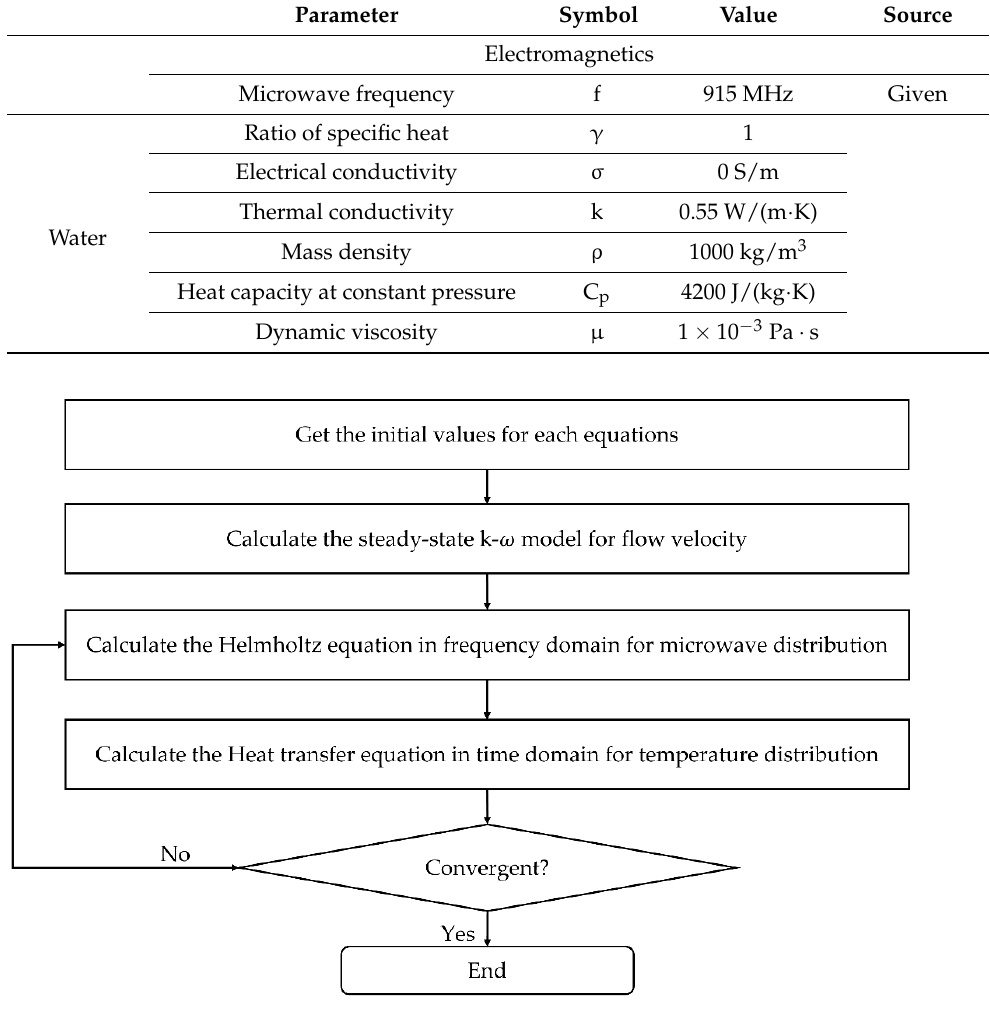
Table 1. Preset parameters in the numerical simulations.